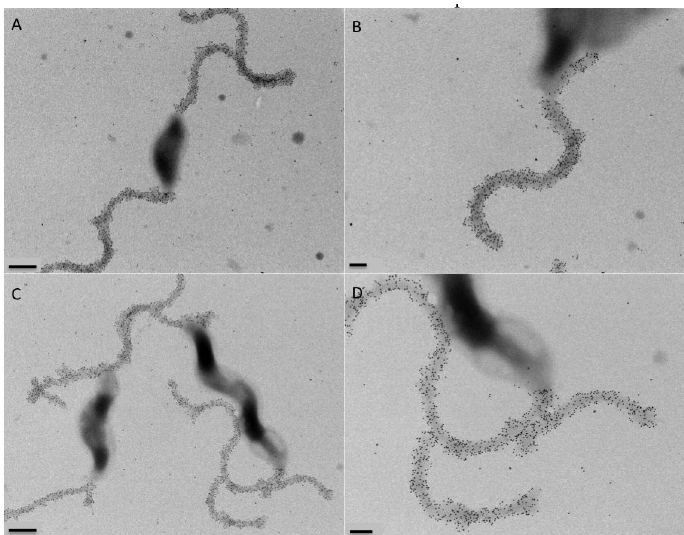
Figure 6. Internal Gp047 expression did not influence binding of externally added Gp047 to C. jejuni cells. Gp047-expressing ( C , D ) and empty pCE 111-28-expressing ( A , B ) C. jejuni cells